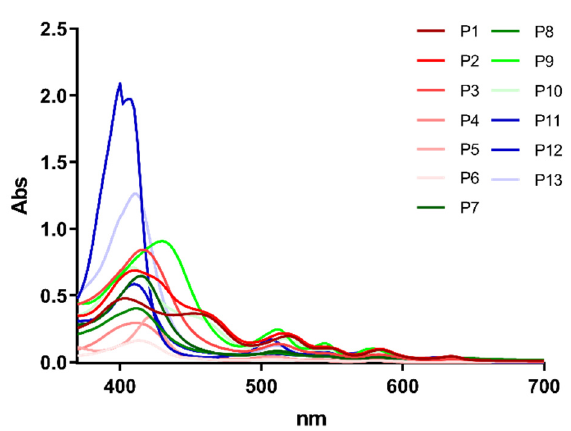
Figure 9. Visible light absorption spectra of diaryl-porphyrins (P1-P13). It can be hypothesized that the positive charge on P11 is strongly delocalized, in fact